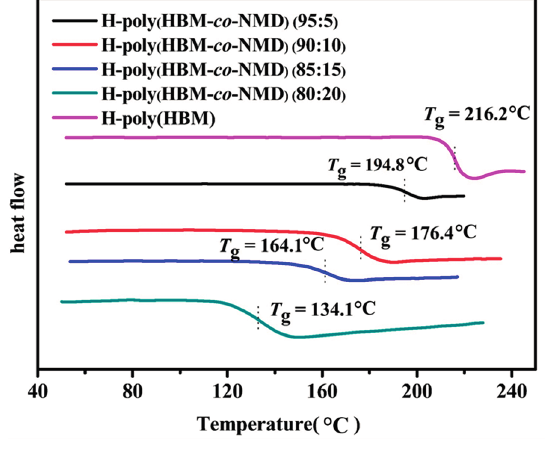
Figure A8. DSC curves of copolymers of HBM and